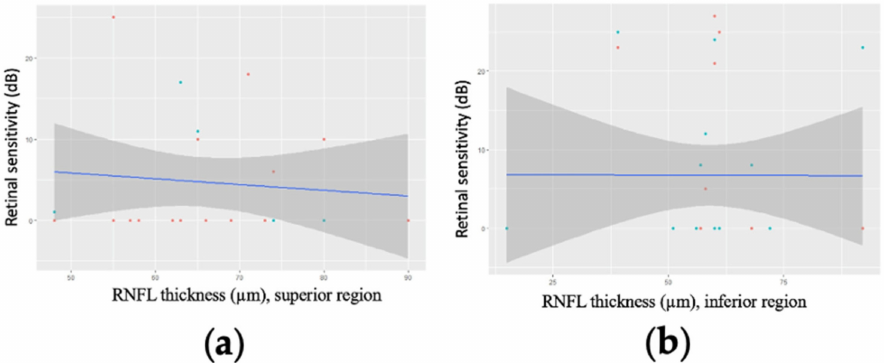
Figure 6. Linear regression modelling of retinal sensitivity as a function of mean retinal nerve fibre layer (RNFL) thickness in regions for two points of the 10-2 visual field for 15 patients (15 eyes) with a mean deviation worse than − 20 dB. ( a ) the superior part of the visual field ( p = 0.622); ( b ) the inferior part of the visual field ( p =